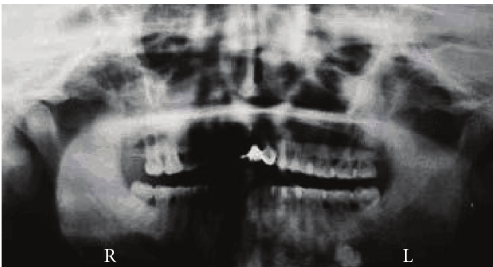
Figure 3: Panoramic radiograph shows an osteoma of the left angle of the